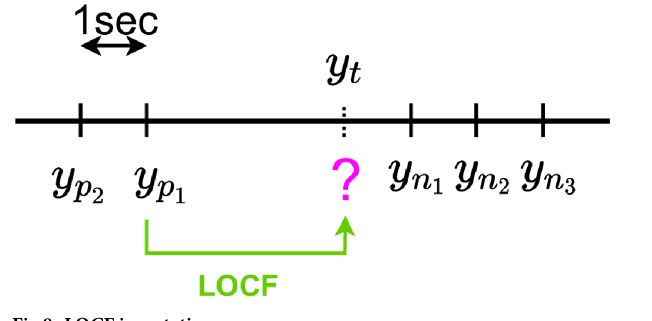
Fig 8. LOCF imputation.